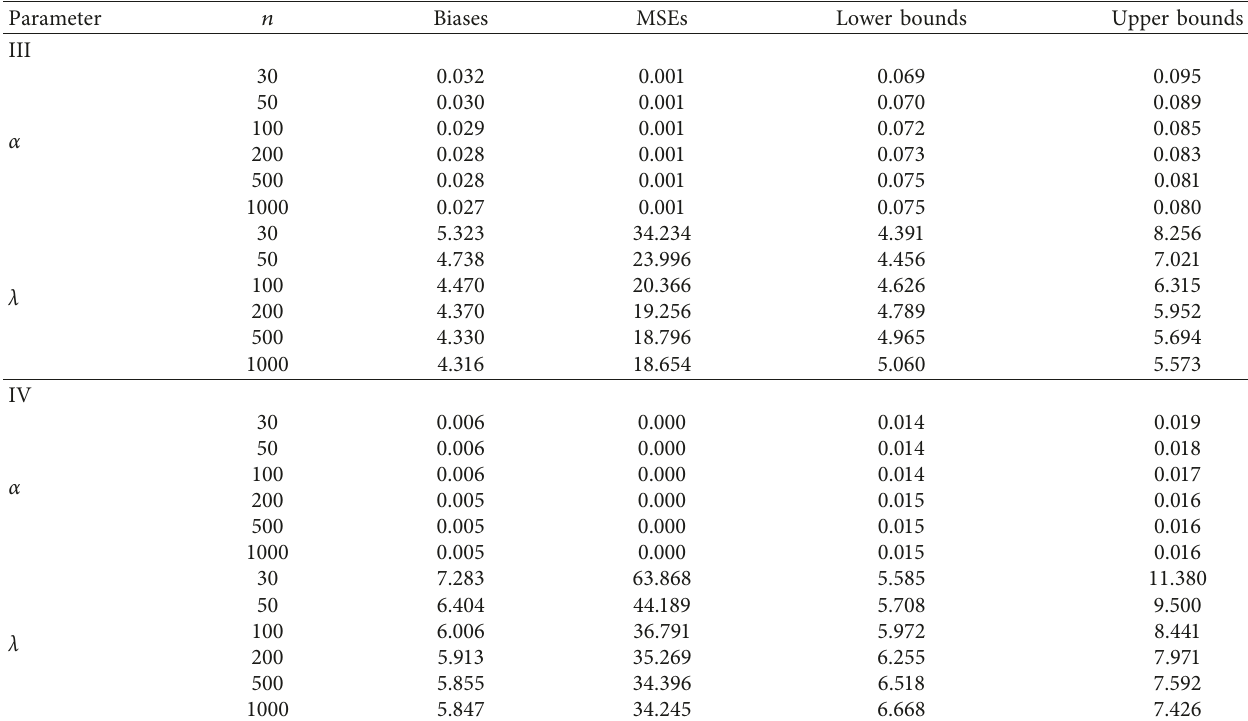
Table 4: Monte Carlo simulation results: biases, MSEs, lower bounds, and upper